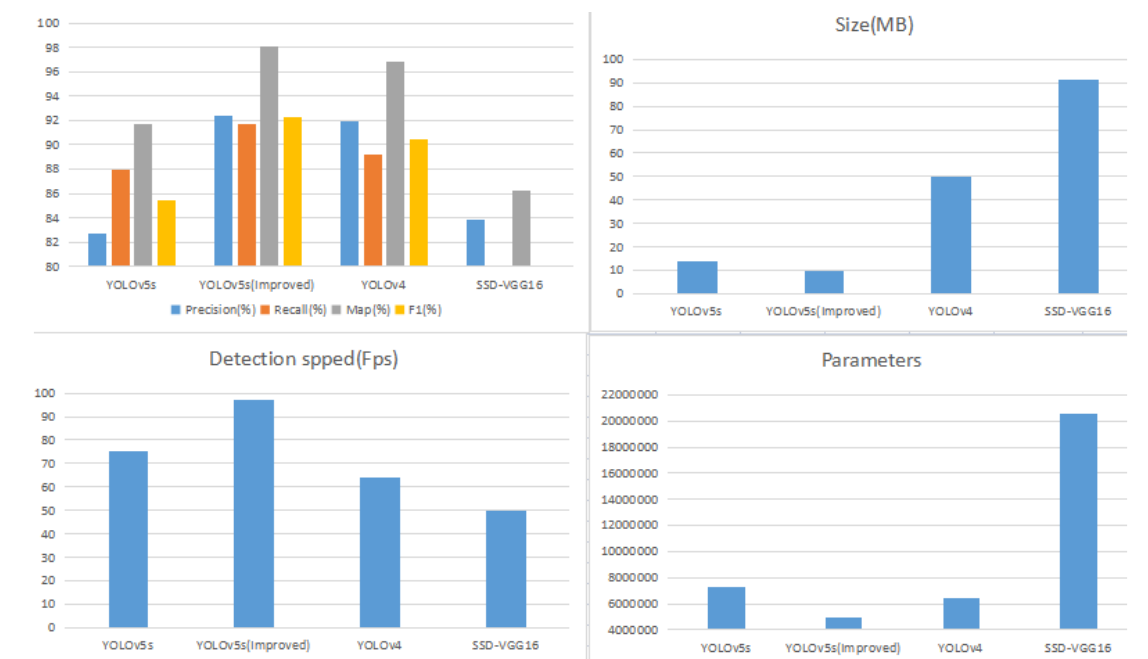
Figure 11. Performance comparison of four target detection networks for group cottonseed damage detection.